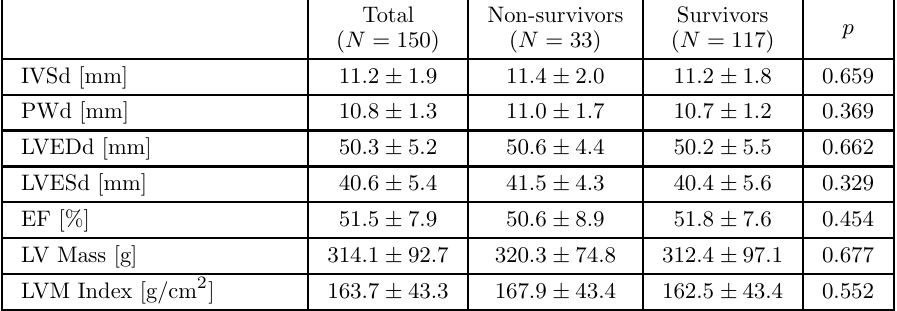
Table 3. Echocardiography results in survivors and non-survivors Total